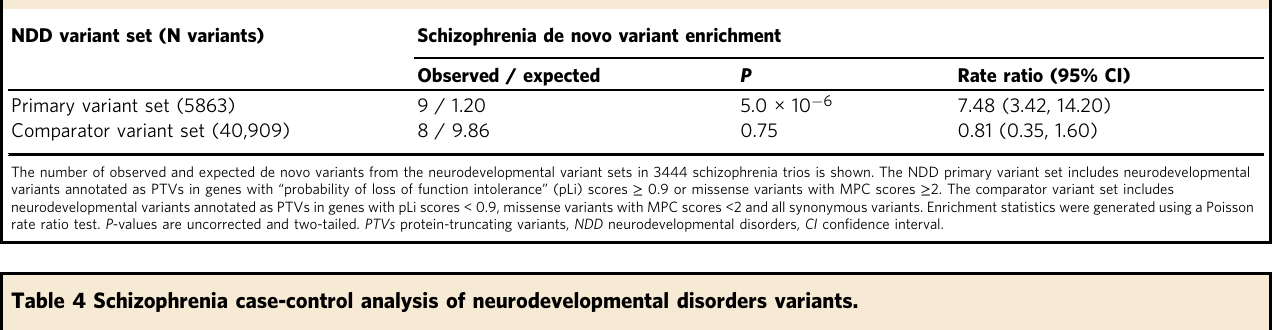
Table 3 Enrichment of neurodevelopmental disorder variants in schizophrenia.